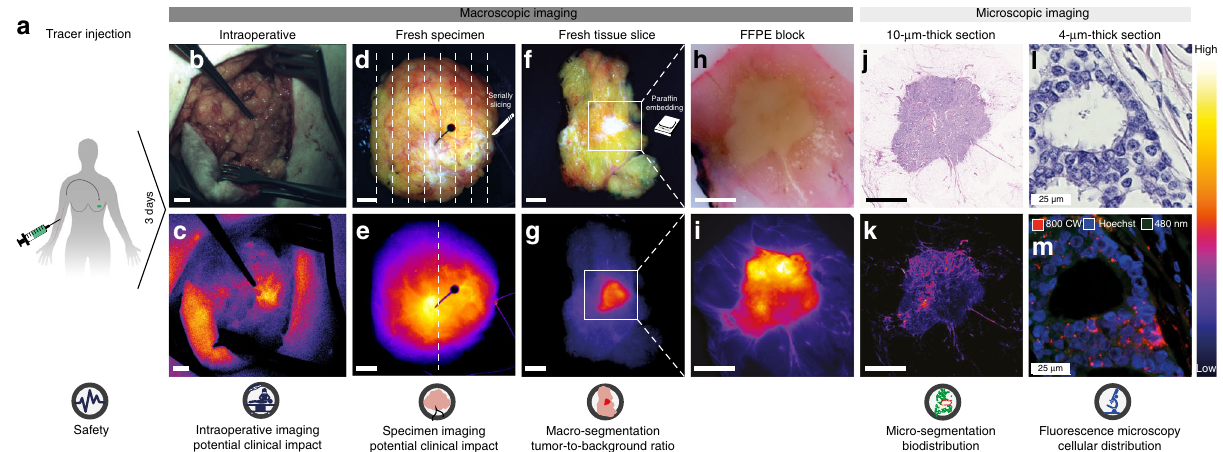
Fig. 1 The clinical analytical framework enabling correlation of intraoperative fl uorescence signals with histopathology, from macroscopic to microscopic levels. a Intravenous administration of bevacizumab-800CW three days prior to surgery. b , c Color image and corresponding fl uorescence image obtained in vivo during surgery to determine potential clinical value. d , e Imaging of the fresh surgical specimen, followed by serially slicing. f , g Imaging of the fresh tissue slices to determine tumor-to-background ratio based on macro-segmentation, followed by paraf fi n embedding. h , i Imaging of formalin- fi xed paraf fi n-embedded (FFPE) blocks to determine heterogeneity of tracer uptake within a tumor. j , k Imaging of 10- µ m-thick tissue sections for micro- segmentation to reveal microscopic biodistribution and correlation with fl uorescence signals from the macroscopic to microscopic level. l , m Fluorescence microscopy to determine tracer distribution on a cellular level. Scale bars represent 1 cm, in l , m the scale bar represents 25 µ